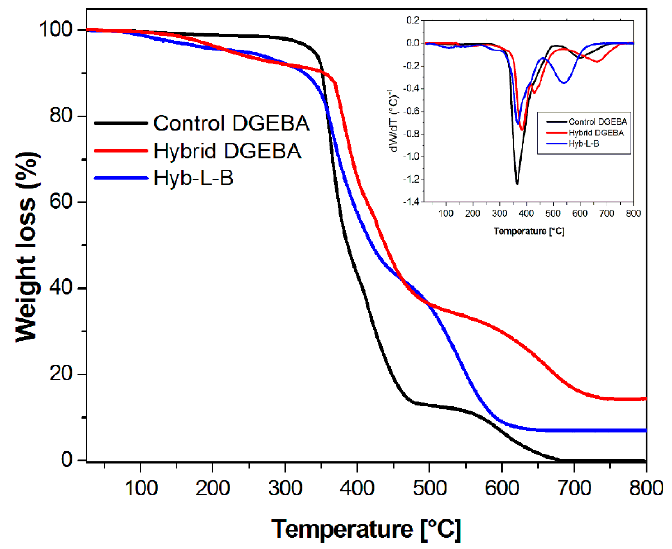
Figure 7. TGA curves of the hybrids cold-cured in presence of PACM amine and of the relative control. In the inset the derivative of the TGA curves obtained for the same systems is shown.